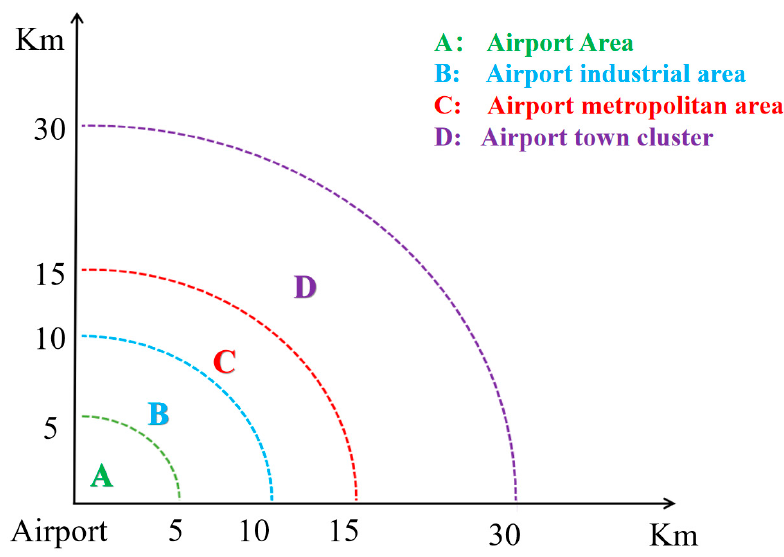
Figure 2. Different development stages of airport economic zones (AEZs).